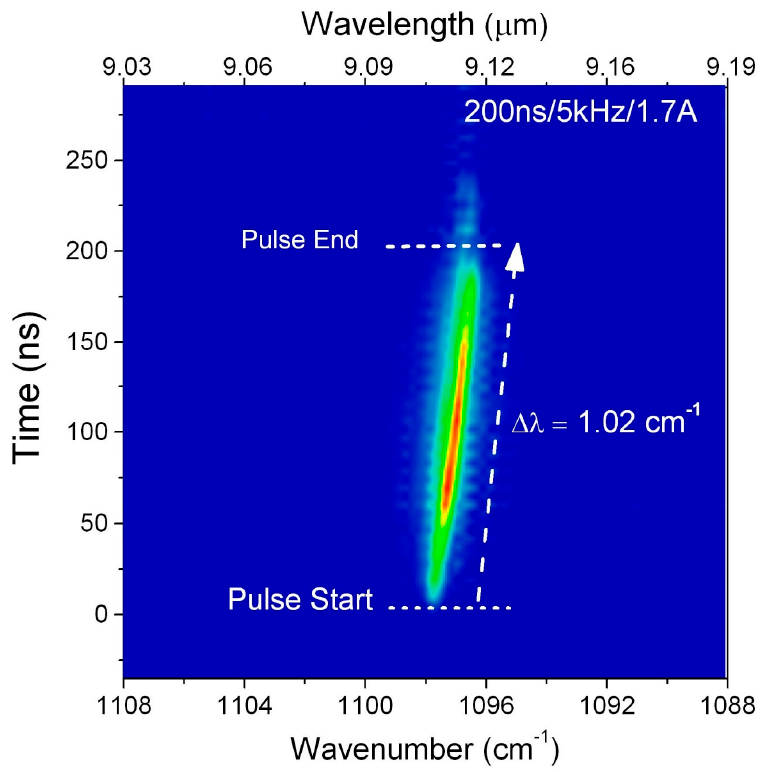
Figure 9. Time-resolved map of emission of CC-QCL operated with 200 ns pulses at 5 kHz repetition rate.